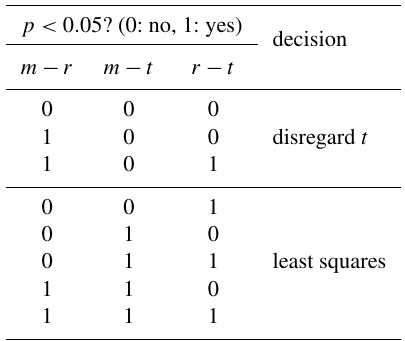
Table 3. Merging scheme based on the one-tailed p value for the correlation between the model ( m ), the reference satellite ( r ), the target satellite ( t ) and soil moisture with a 0.05 significance